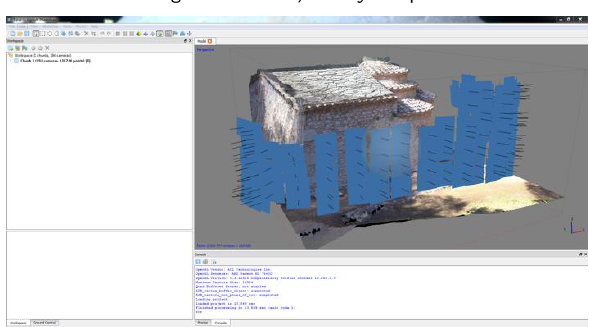
Figure 5. DEM, Trinity Chapel.